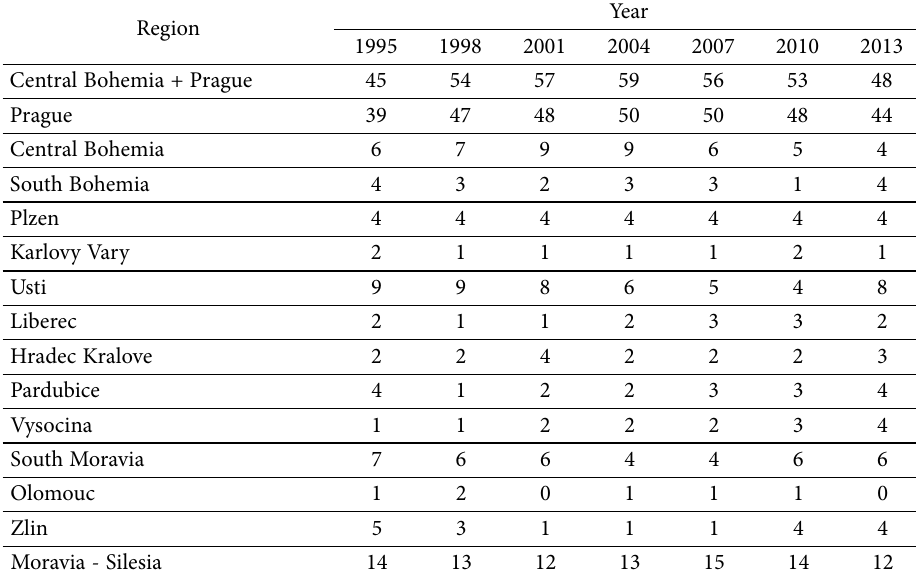
Table 1. Regional differentiation of 100 largest companies